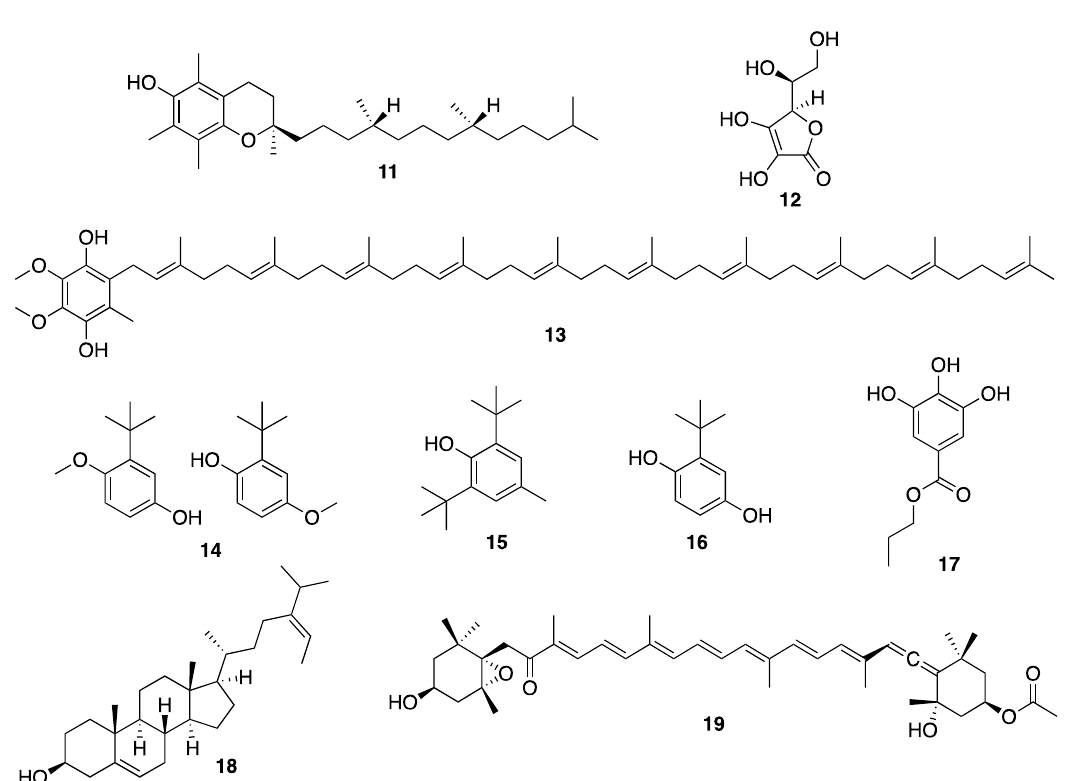
Figure 3. Structures of R-tocopherol ( 11 ), ascorbic acid ( 12 ), ubiquinol ( 13 ), hydroxyanisole ( 14 ), butylated hydroxytoluene ( 15 ), tertiary butylhydroquinone ( 16 ), propyl gallate ( 17 ), fucosterol ( 18 ), and fucoxanthin ( 19 ).